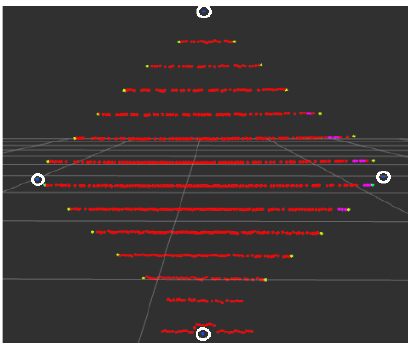
Figure 9. Board edges in LiDAR data